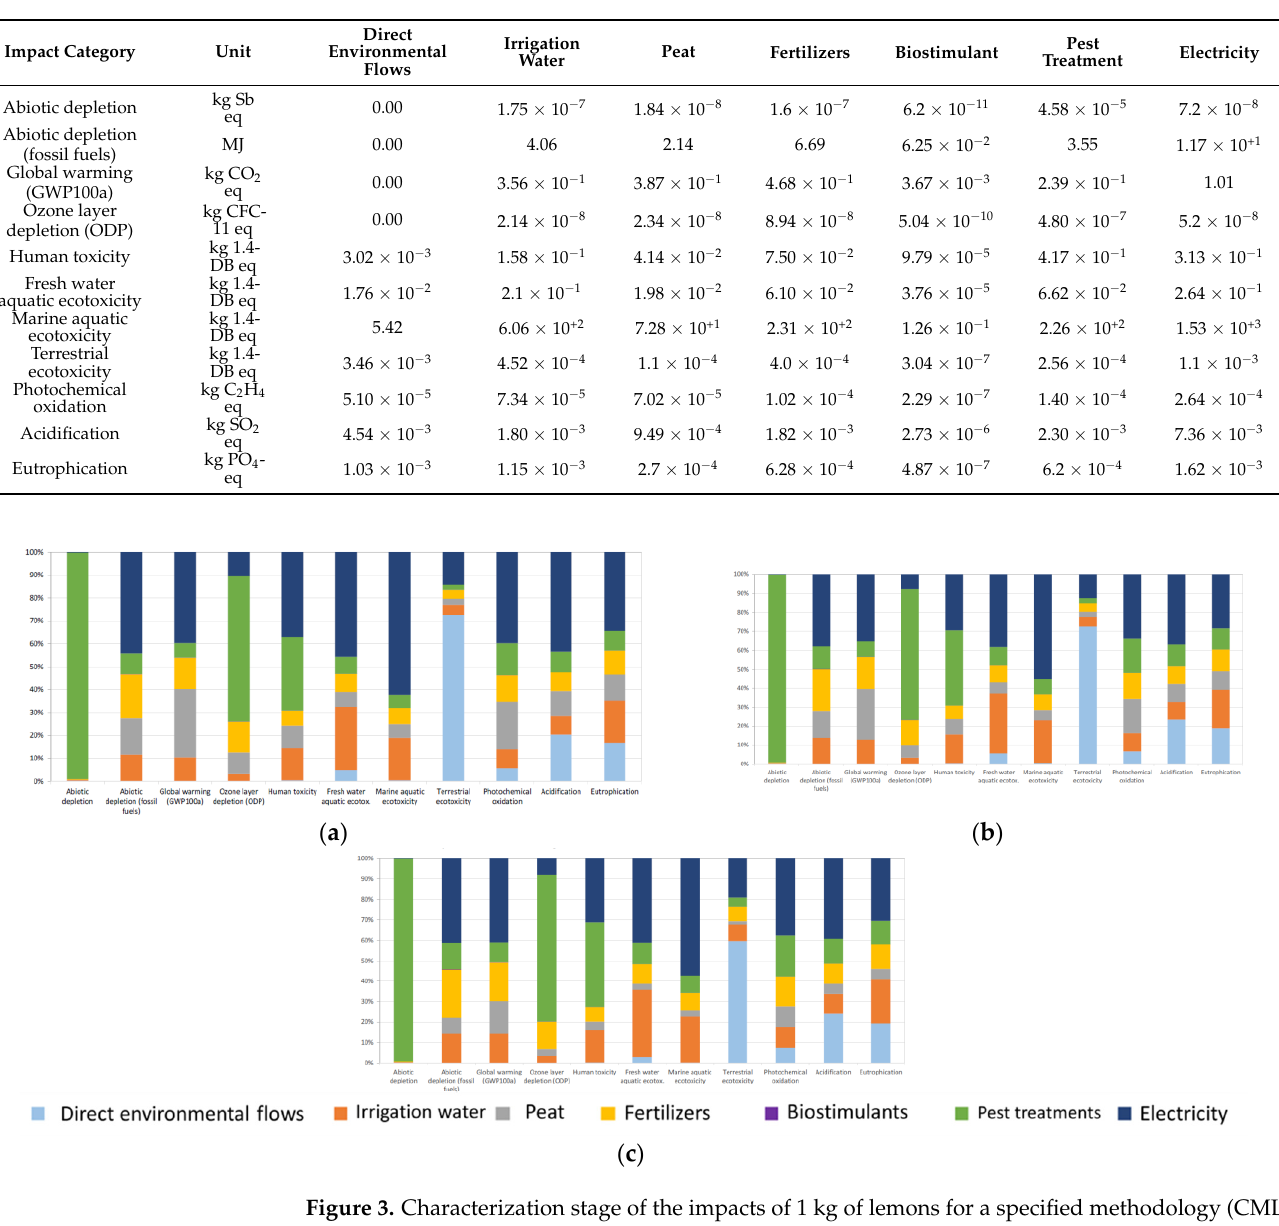
Table 8. S75 Characterization stage of the impacts of 1 kg of lemons for the specified methodol- ogy (CML-IA baseline). Absolute values. Long-term emissions (>100 years) are included, and infrastructure processes are excluded.